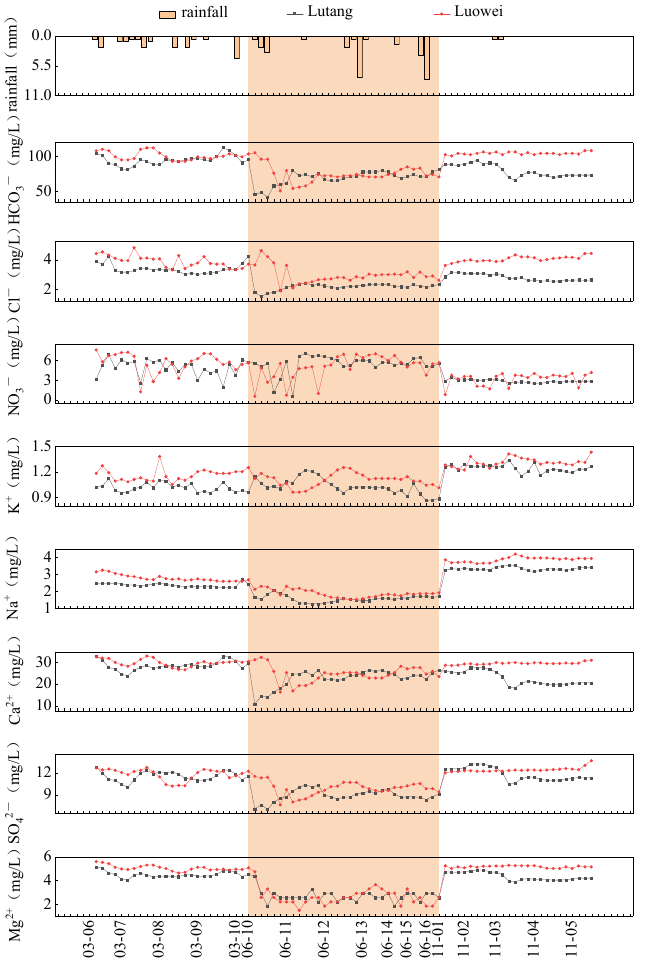
Figure 4. Average concentration variations of ions at different water level operation periods.